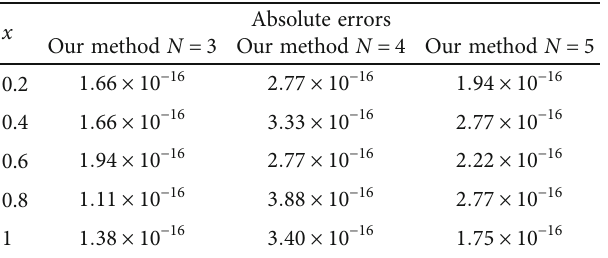
Table 1: The comparisons between the absolute errors of di ff erent N for Example